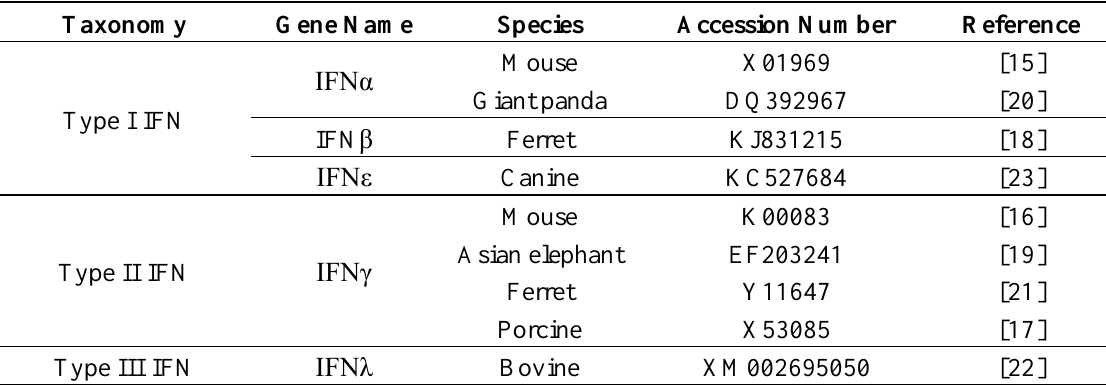
Table 1. List of the interferons identified in some